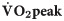
Mean (with SD) V˙O2peak stratified on fulfilling and not fulfilling criteria for V˙O2max max in patients diagnosed with breast, prostate or colorectal cancer (n = 535).Abbreviations: RER = Respiratory Exchange Ratio; RPE = rates of perceived exertion on Borg scale 6–20; V˙O2 = oxygen uptake; V˙CO2 = carbon dioxide production. Tanaka, HRmax = 208 - (0.7*age), Plateau, ΔV˙O2 = a change in V˙O2 of less than 150, 80 or 50 ml/min from one minute to the next minute.